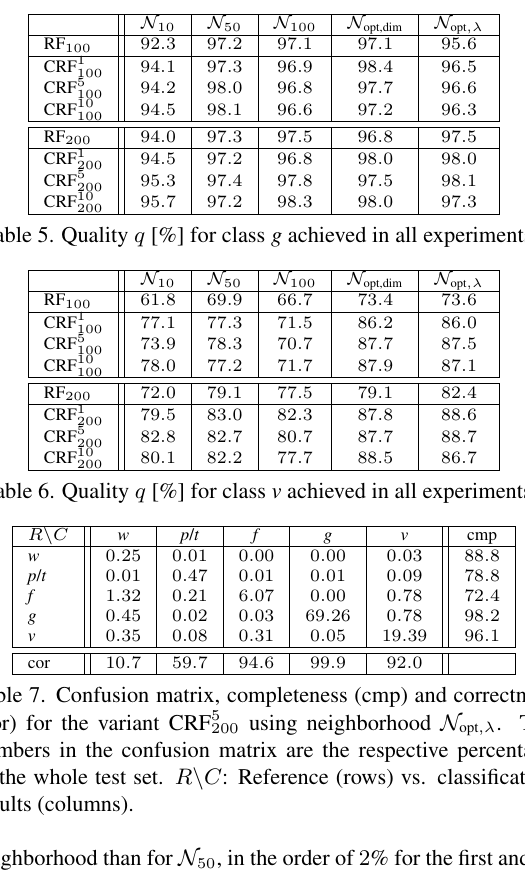
Table 4. Quality q [%] for class f achieved in all experiments.